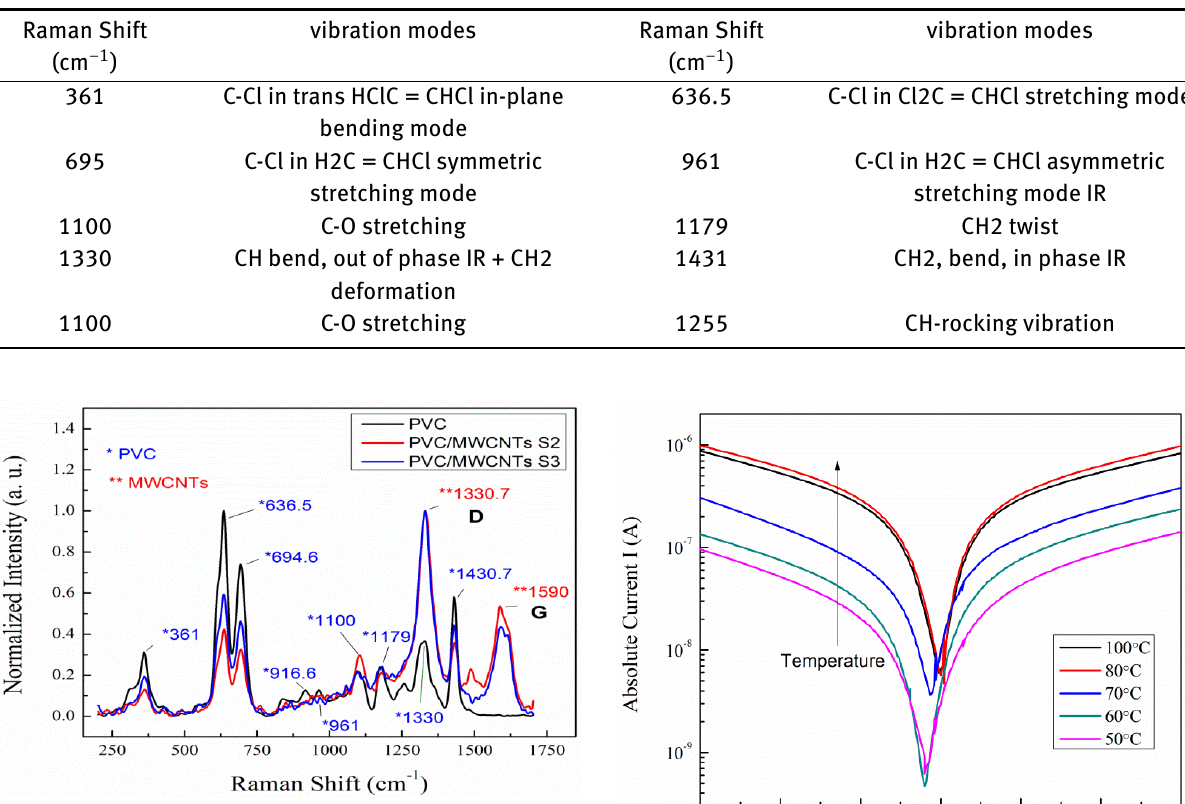
Table 2: The main peaks of PVC in Raman spectrum